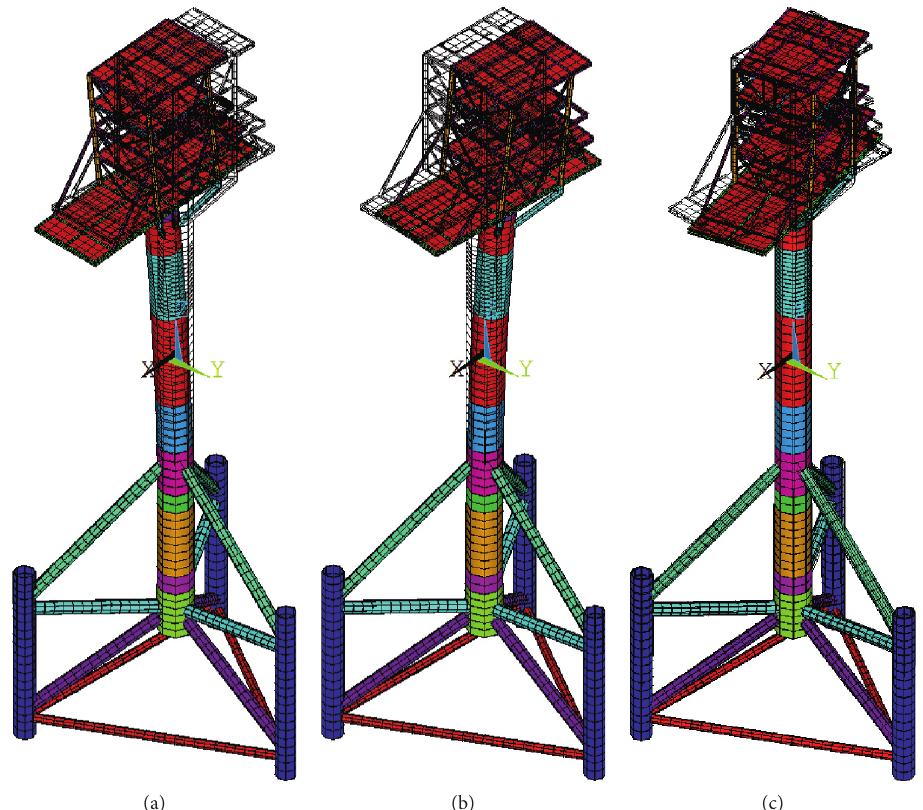
Figure 5: (a) First mode: bending moment in the longitudinal direction. (b) Second mode: bending moment in the transverse direction. (c) Third mode: torsion